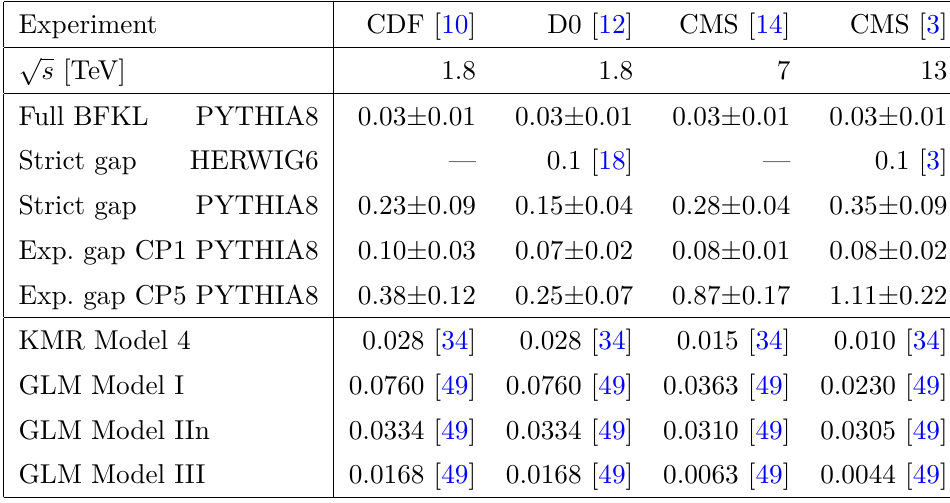
Table 3 . Fitted scale factors S and predicted survival probabilities S prob for different experimental √ conditions, center-of-mass energies s and gap definitions. The fit is done via a χ 2 scan of the sur- vival probabilities. The uncertainties we quote correspond to the 97.5% confidence interval derived from the χ 2 parameter scan. Assuming that the additional factors between S and S √ smooth dependence on kinematics and s , we can study the relative difference between both